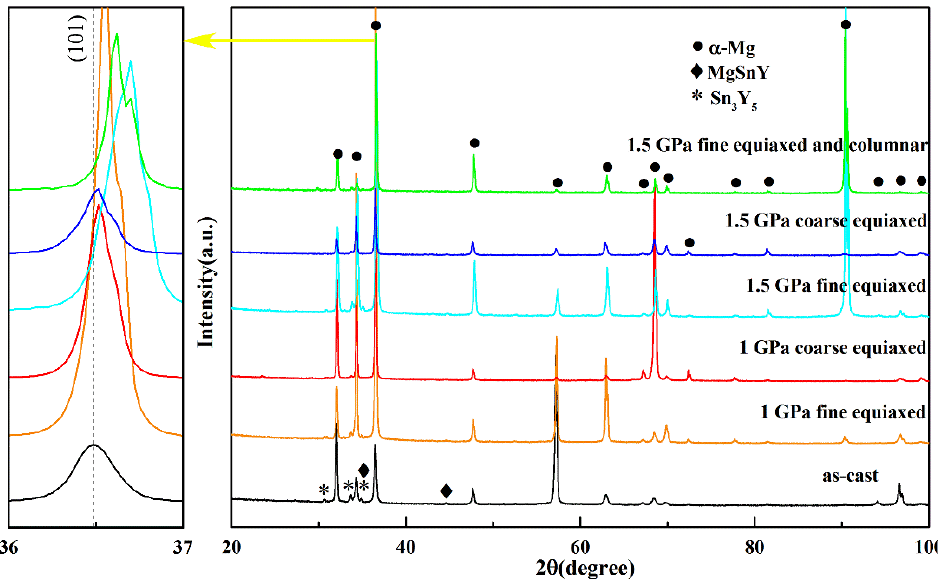
Figure 3. XRD spectra of the Mg-1Sn-2.5Y alloys solidified under high pressures. The macrostructure and microstructure of the Mg-1Sn-2.5Y alloy solidified under 1